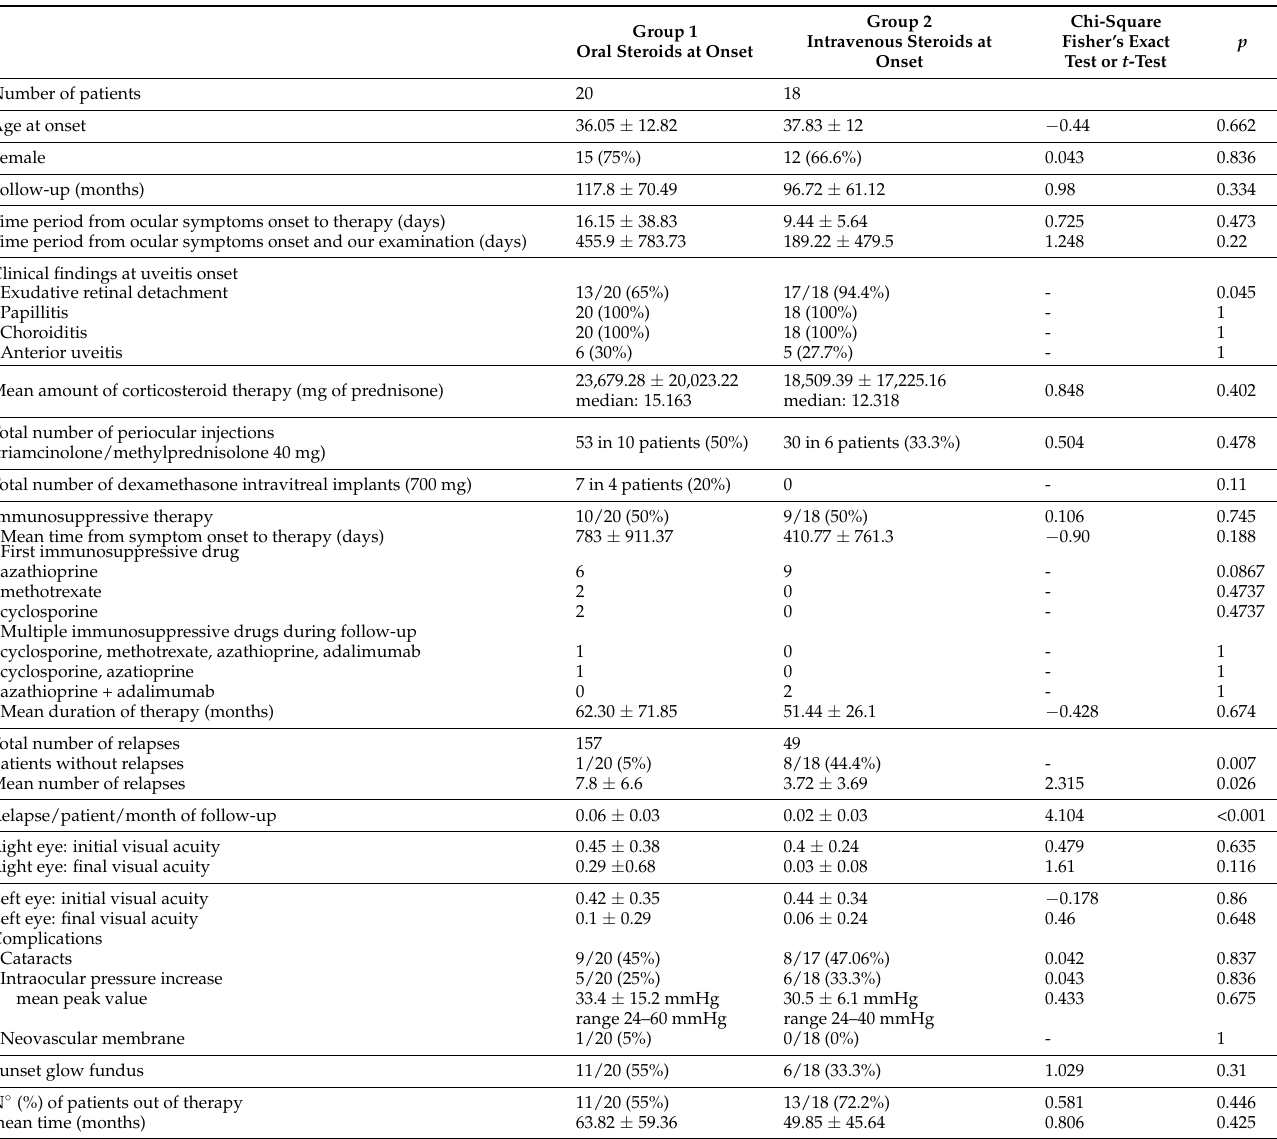
Table 2. Demographics and clinical features of patients with Vogt–Koyanagi–Harada disease accord- ing to the route of administration of corticosteroids at onset: group 1 oral and group 2 intravenous